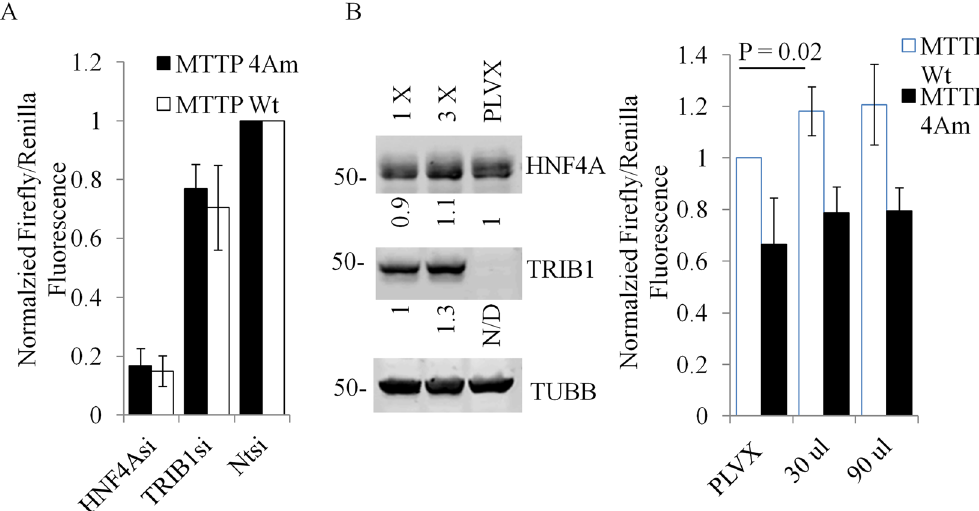
Figure 3. Overexpression of TRIB1 in HuH-7 cells increases MTTP promoter assay activity but does not affect HNF4A protein level. ( A ), HuH-7 cells were treated for 48 h with indicated siRNAs, washed and transfected with MTTP constructs (and Renilla internal control) for an additional 24 h. Samples were lysed in Passive Lysis Buffer and processed for fluorescence. Results represent the means of 3 experiments ( ± S.D). Values are normalized to the Non-Target (NT) siRNA-treated samples. ( B ), A stable pool of HIS-TRIB1 expressing cells was generated by transduction with increasing viral titer (1X, 3X). A control pool was generated using the empty vector (PLVX at 3X titer). Cells transfected with MTTP promoter and renilla internal control constructs for 24 h were lysed and analyzed by Western blotting (left) or luciferase assay (right). Data represent the mean of 5 experiments normalized to PLVX (Wt MTTP) values, ± S.D. Quantifications of the Western blot are relative to TUBB and normalized to either PLVX (HNF4A) or 1X MOI (TRIB1). Statistical significance was assessed using the Student’s 2-tailed